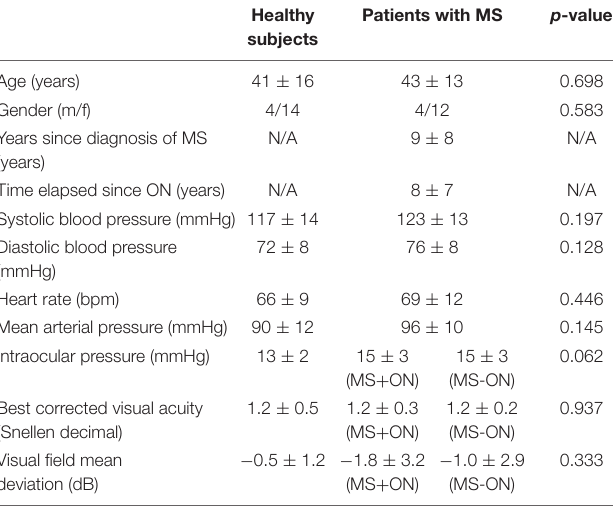
TABLE 1 | Baseline characteristics of the two study groups.